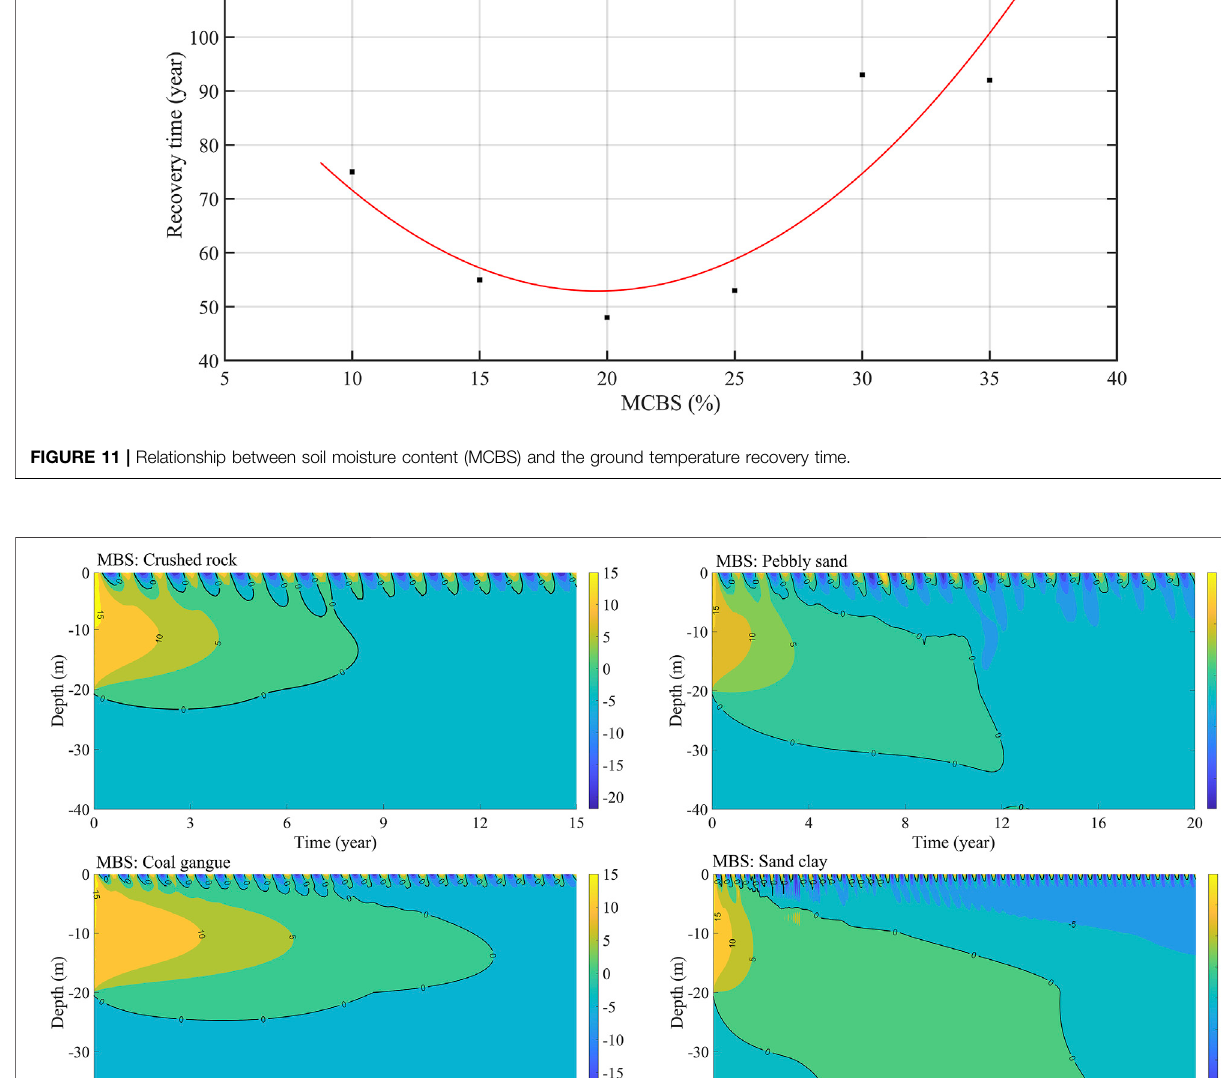
Frontiers in Earth Science |